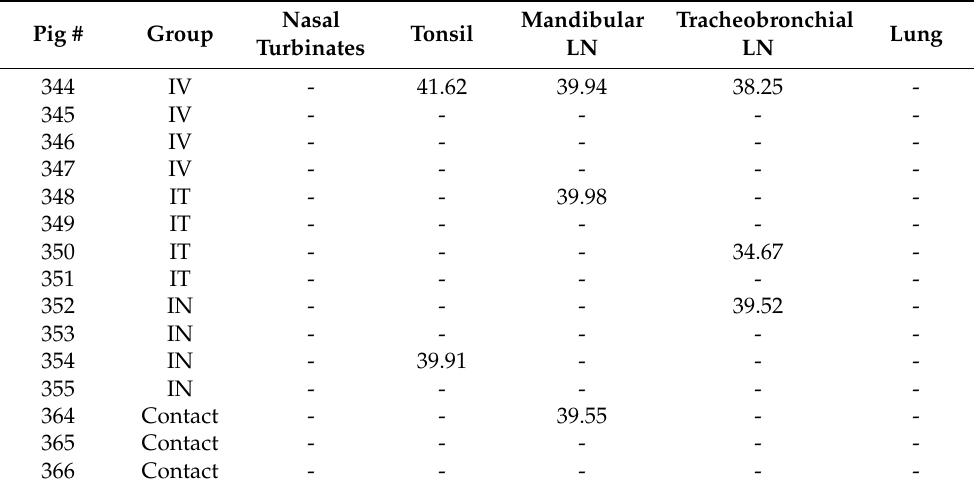
Table 3. rRT-PCR Ct values for select tissues of challenged pigs and contacts.